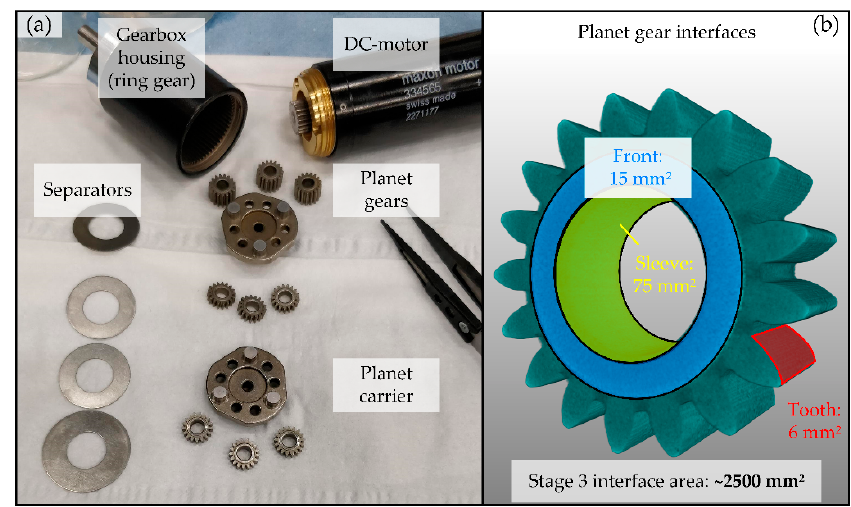
Figure 2. ( a ) Disassembled gearbox with numerous tribological interfaces. ( b ) Model of planet gear, indicating three different tribological interfaces.